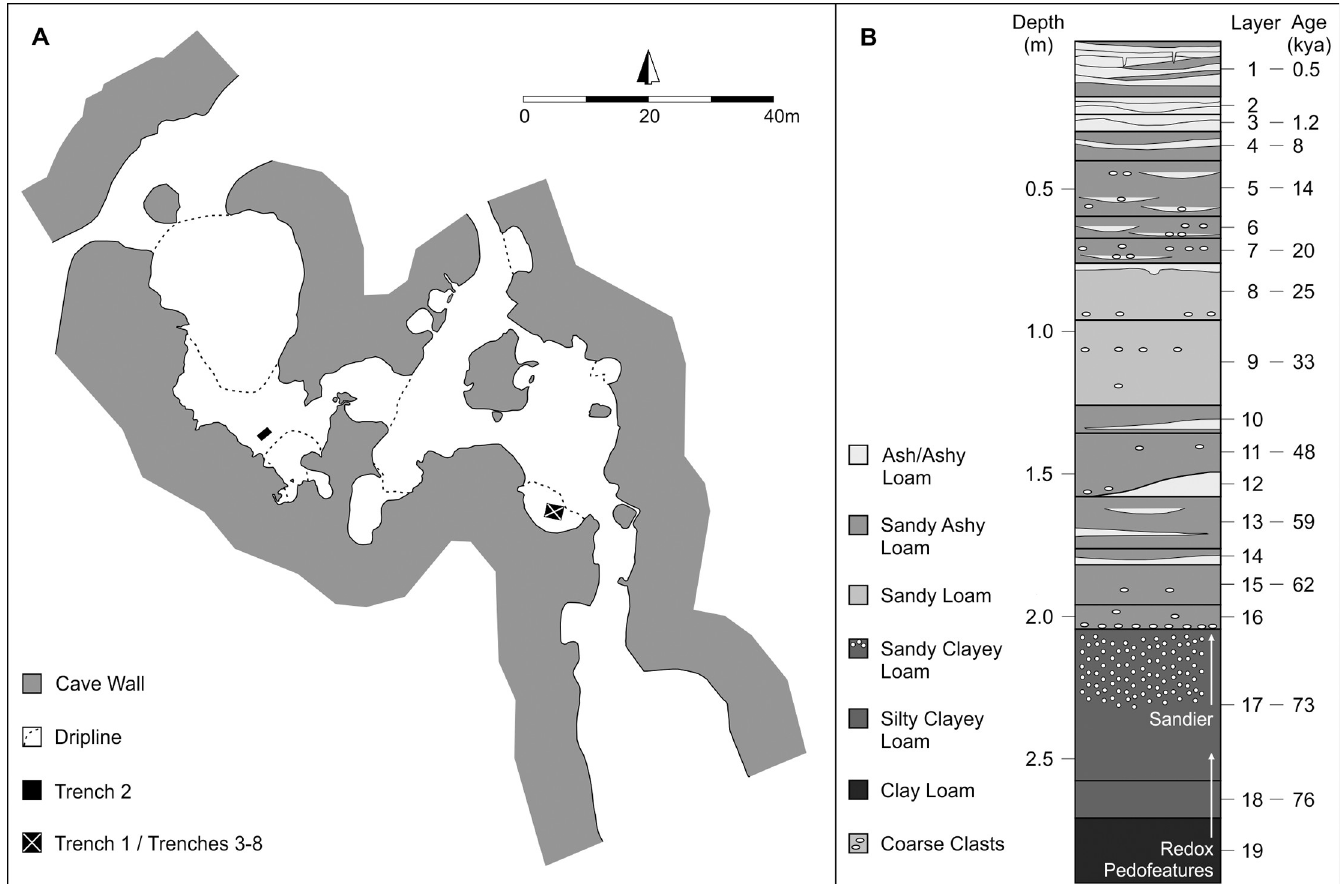
Fig 3. Panga ya Saidi site plan (A) and representative stratigraphic and chronological sequence (B).